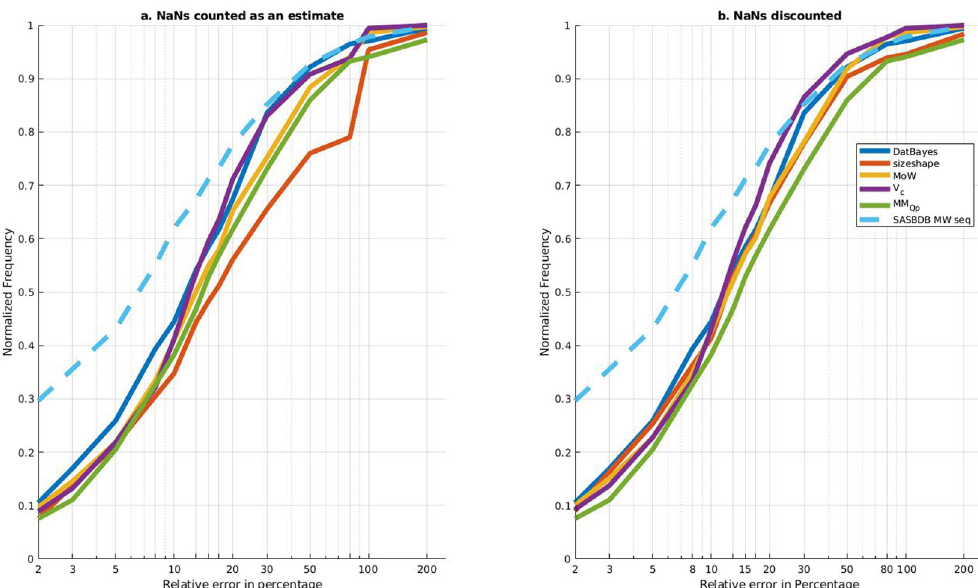
Figure 8. ROC-like curves for experimental data from SASBDB. ROC curves of relative error against normalized frequency for experimental data from all published SASBDB entries, 375 datasets in total. The x-axis is log-scaled to better discern the performance. The actual MM is taken to be the user submitted experimental MM. As a control, the actual MM is plotted against the MM from the user submitted sequence. Right : Counting NaNs as a bad estimate, and normalizing by the total number of cases. Left: Ignoring NaNs, normalizing by the total number of cases minus the number of